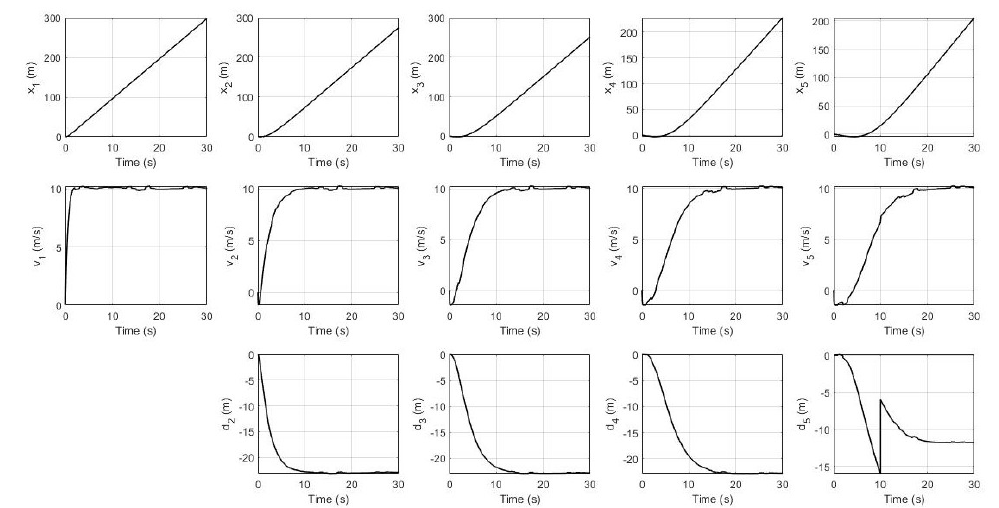
Figure 11. System’s response with sensor S3 fault in the 5th